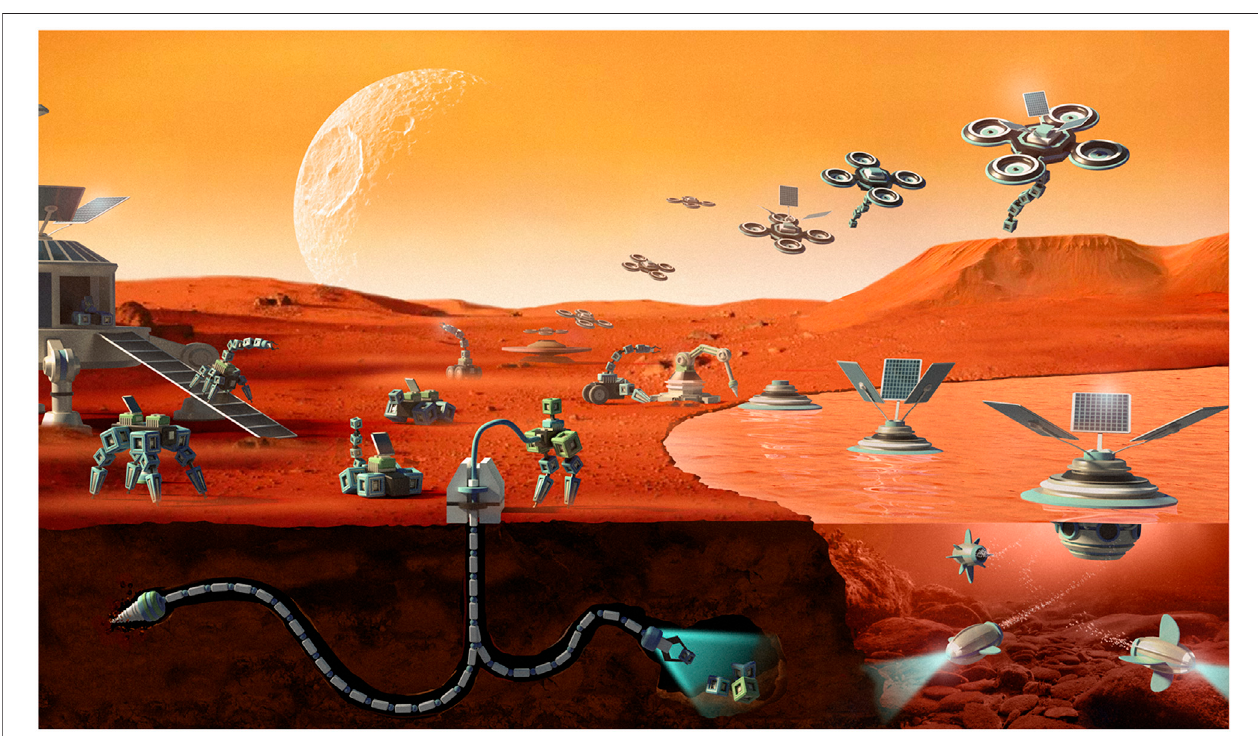
FIGURE 3 | Artist impression of evolving robots in